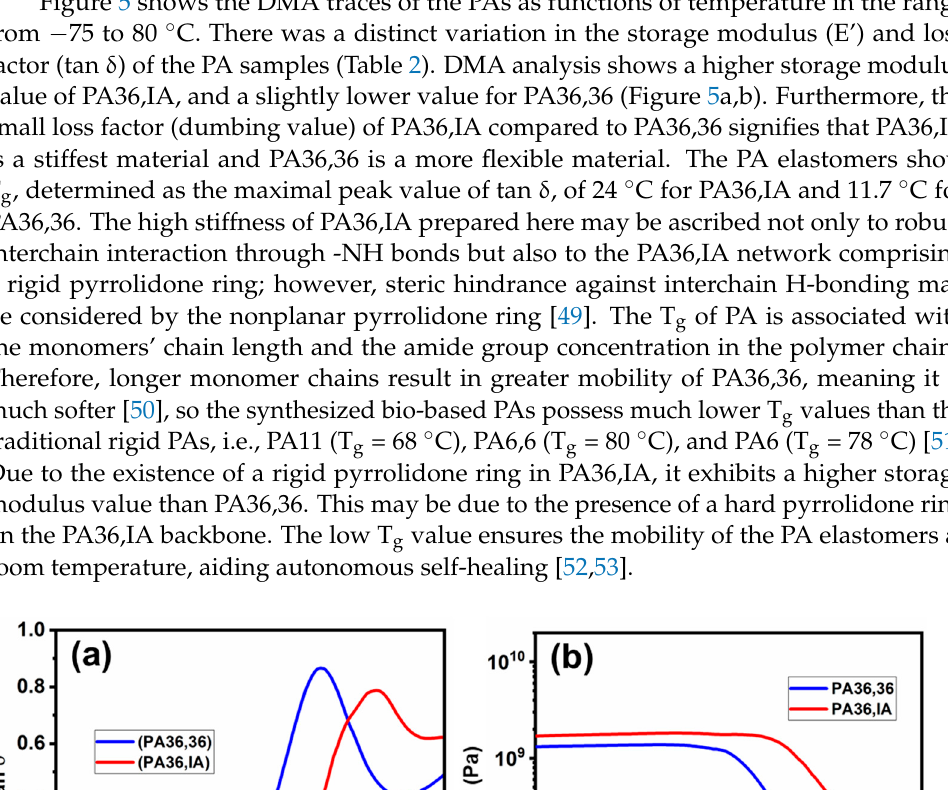
Table 2. Thermal degradation and glass transition temperatures of bio ‐ based PA elastomers. Samples